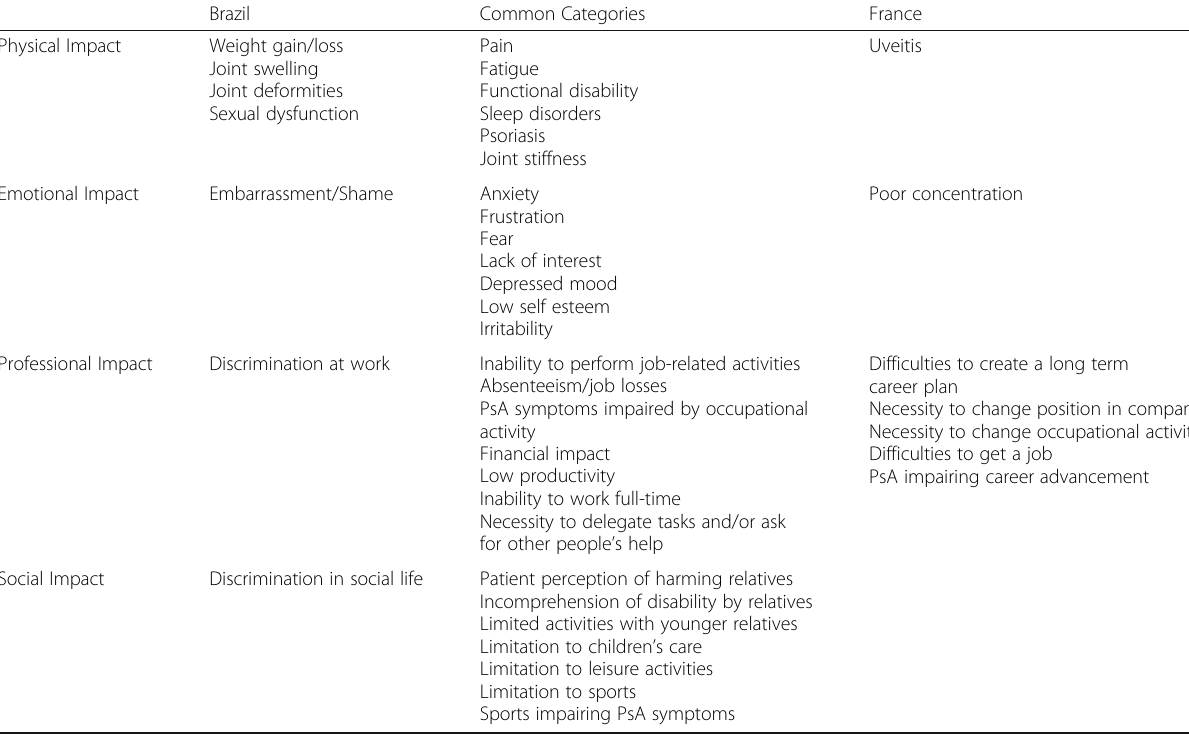
Table 3 Impact of PsA: comparison of categories found in Brazil and France Brazil Common